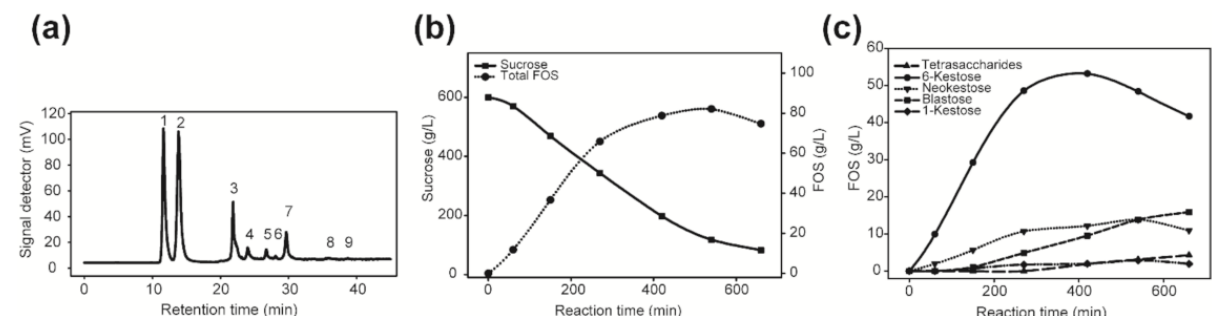
Figure 4. Transfructosylating reaction analysis catalyzed by RdINV. ( a ) HPLC chromatogram of the mixture obtained after 11 h reaction. Reaction conditions: 600 g/L sucrose at 60 ◦ C. Peaks correspondence: (1) fructose, (2) glucose, (3) sucrose, (4) blastose, (5) neokestose, (6) 1-kestose, (7) 6-kestose, (8) neonystose, and (9) nystose. ( b ) Total fructooligosaccharides (FOS) production vs. the hydrolyzed sucrose. ( c ) Evolution of the different FOS detected in the reaction.